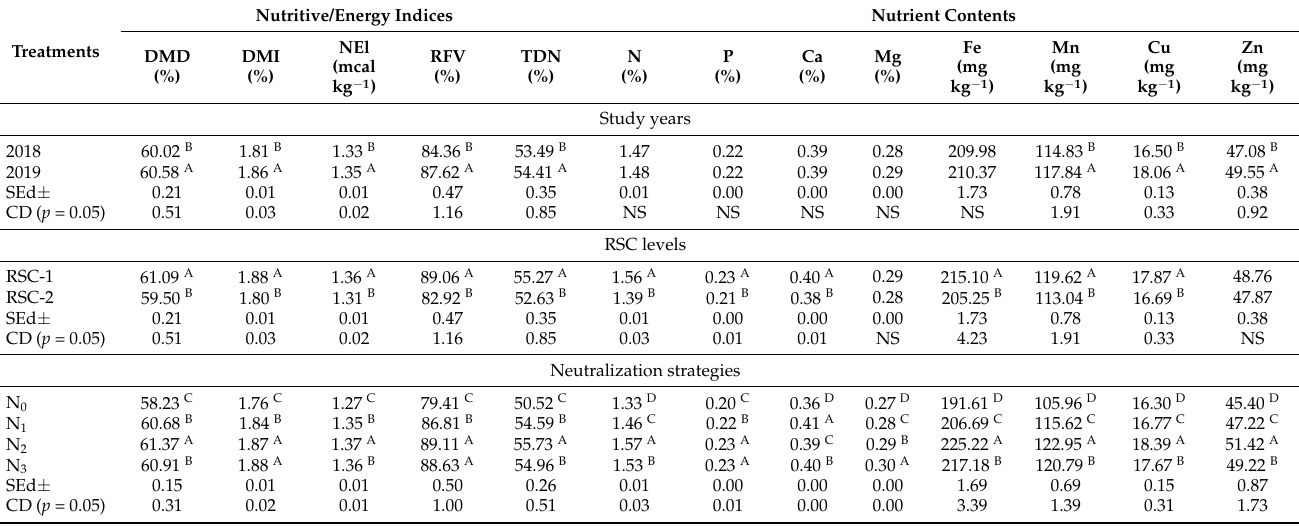
Table 4. Fodder quality parameters and nutrient content of summer sorghum as influenced by study years, RSC levels and neutralization